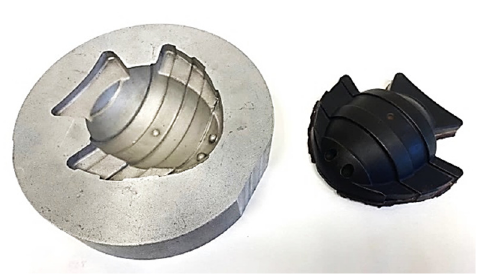
Figure 1. Mold manufactured by EDM ( left ) and EDM electrode ( right ).